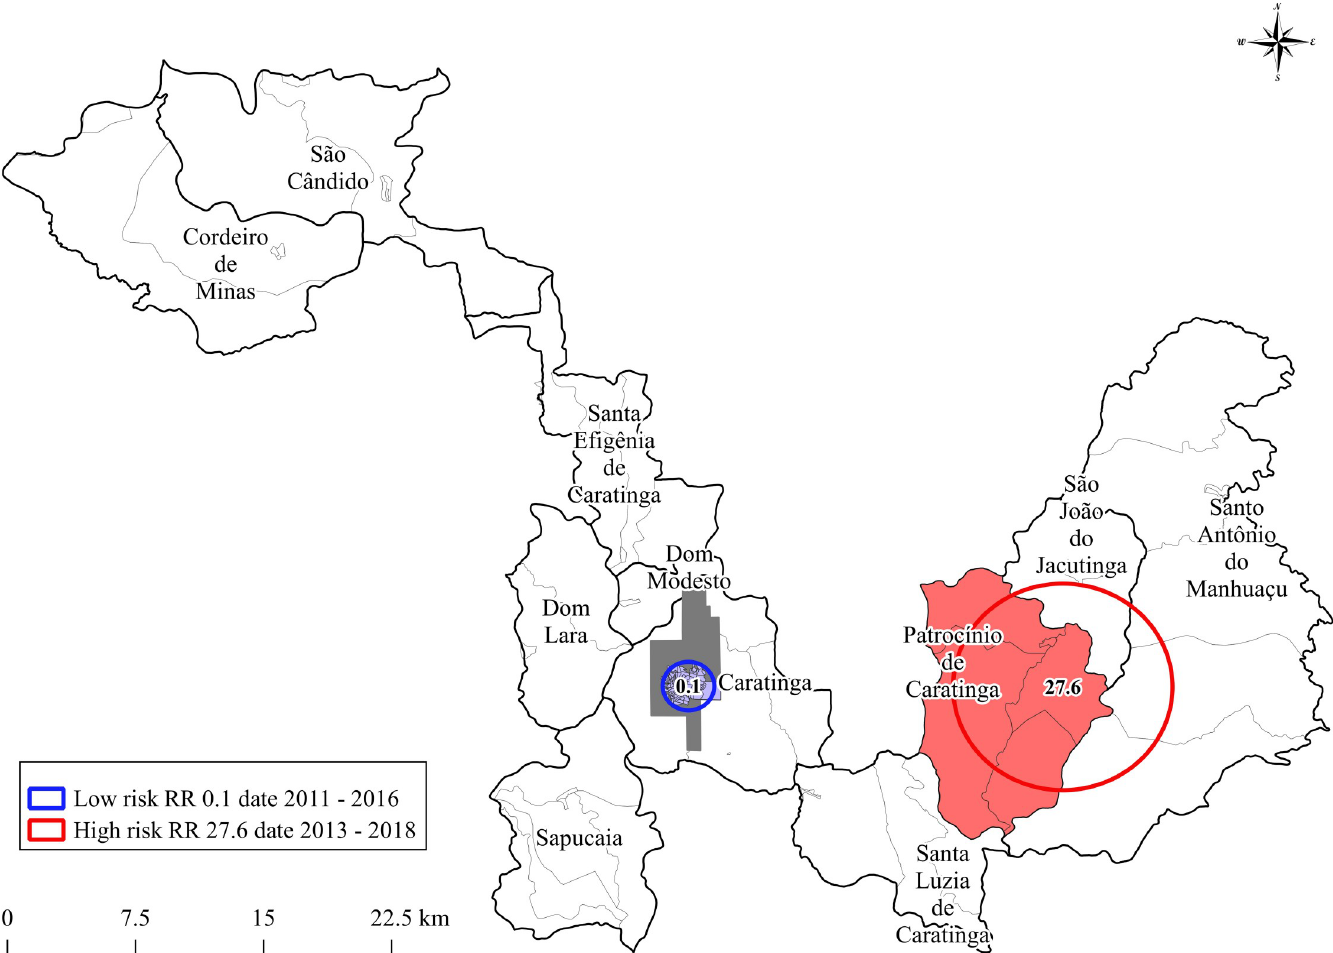
Fig 8. Relative risk of ATL cases reported in the city of Caratinga and in the district of Patrocı´nio de Caratinga (www.ibge.gov.br).